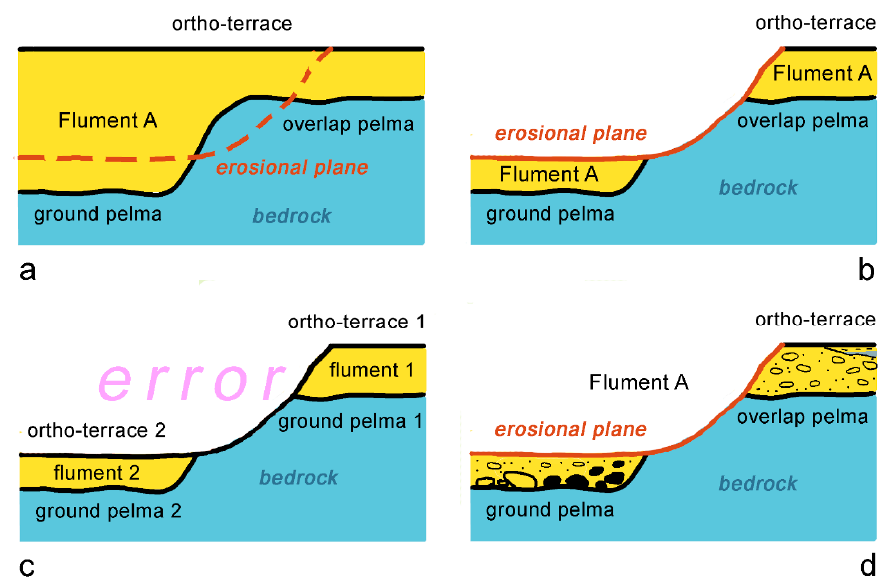
Figure 10. Flument overlap. ( a ) An overlapping flument causes two pelmas, a ground pelma and overlap pelma. ( b ) An erosional plane separates the two pelmas and the deeper part of the flument from its higher part. ( c ) A wrong interpretation of the separated fluments, actually presenting one flument. ( d ) An easier interpretation, using the flument structure in case both flument proportions show, respectively, the typical basal and upper facies of a flument.